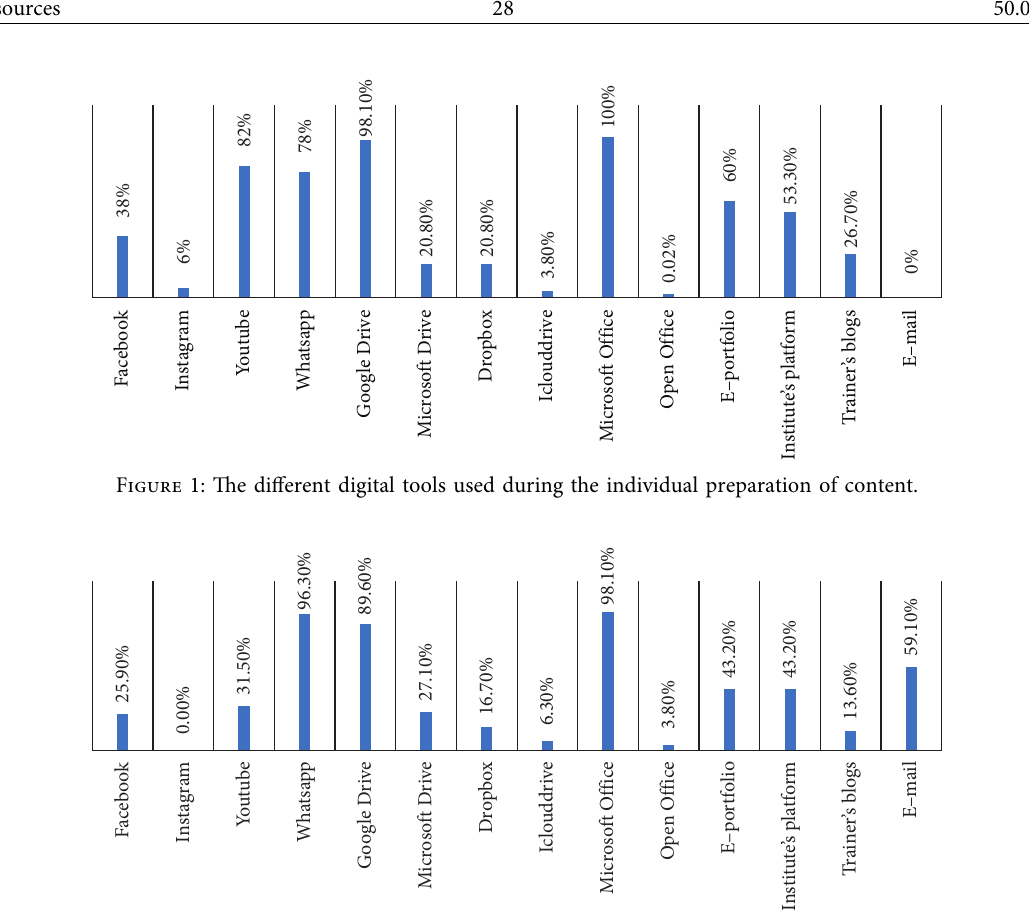
Figure 2: The various digital tools used during group preparation of